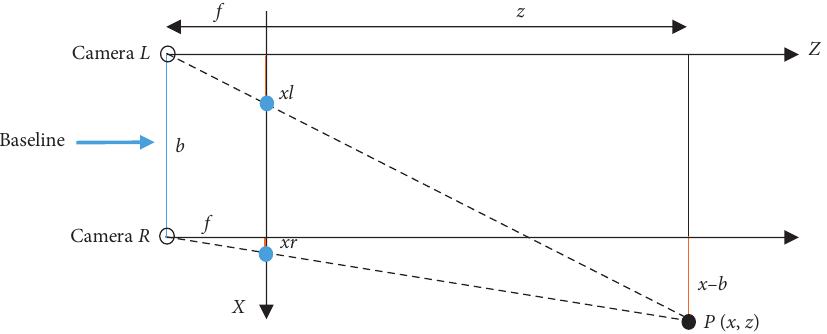
Figure 5: Range detection.